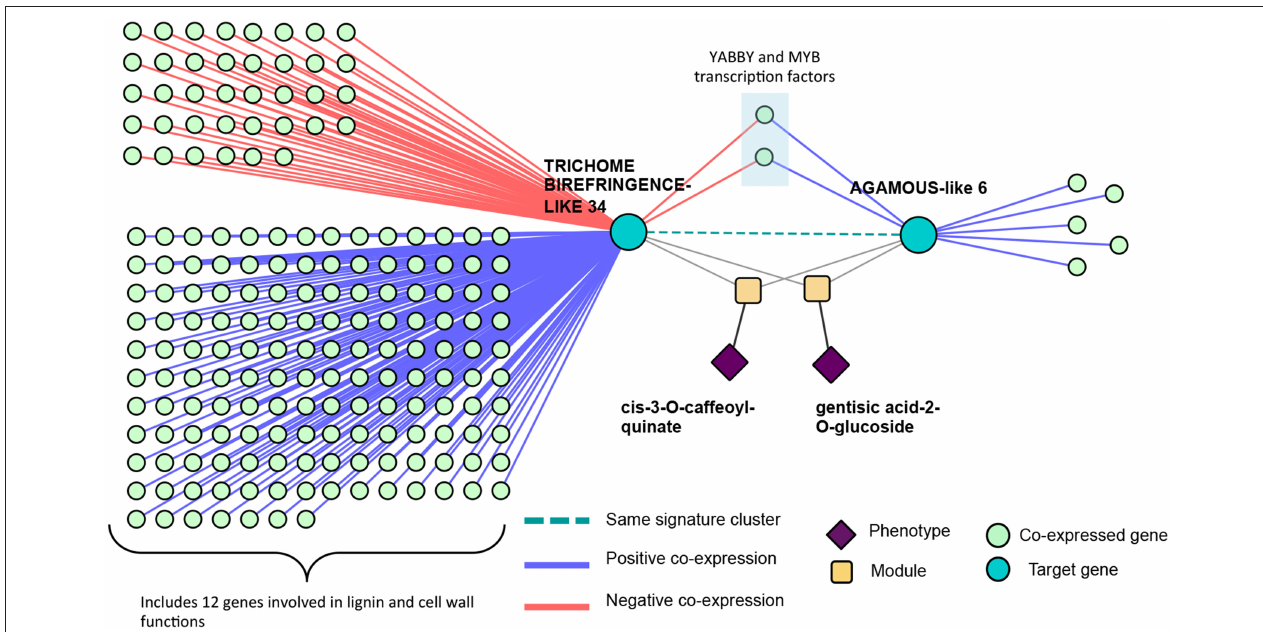
FIGURE 14 | Co-expression lines of evidence. Co-expression relationships of the signature cluster consisting of TBL34 and AGL6 from Figure 12